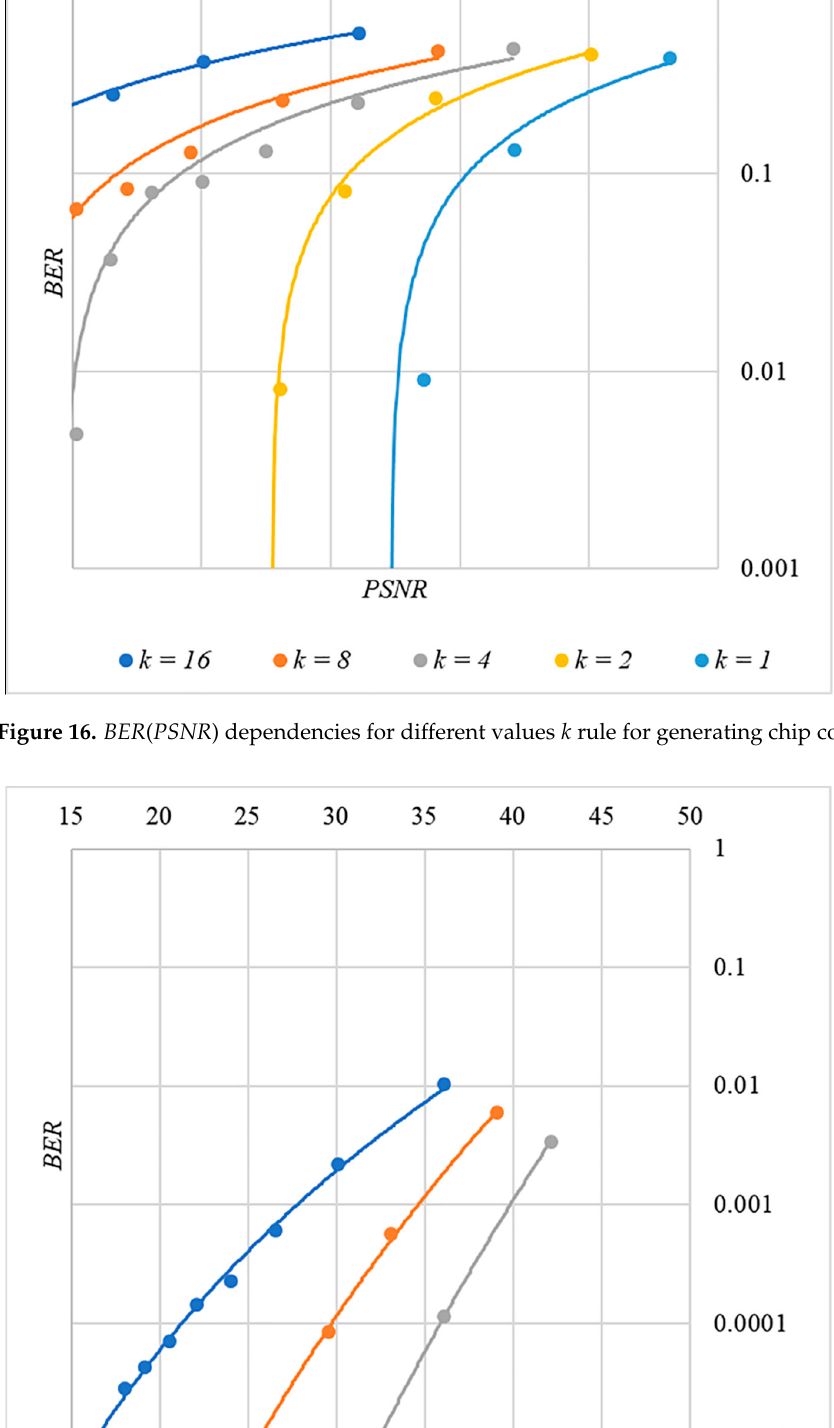
Figure 15. BER ( PSNR ) dependencies for different values k rule for generating chip codes № 3.